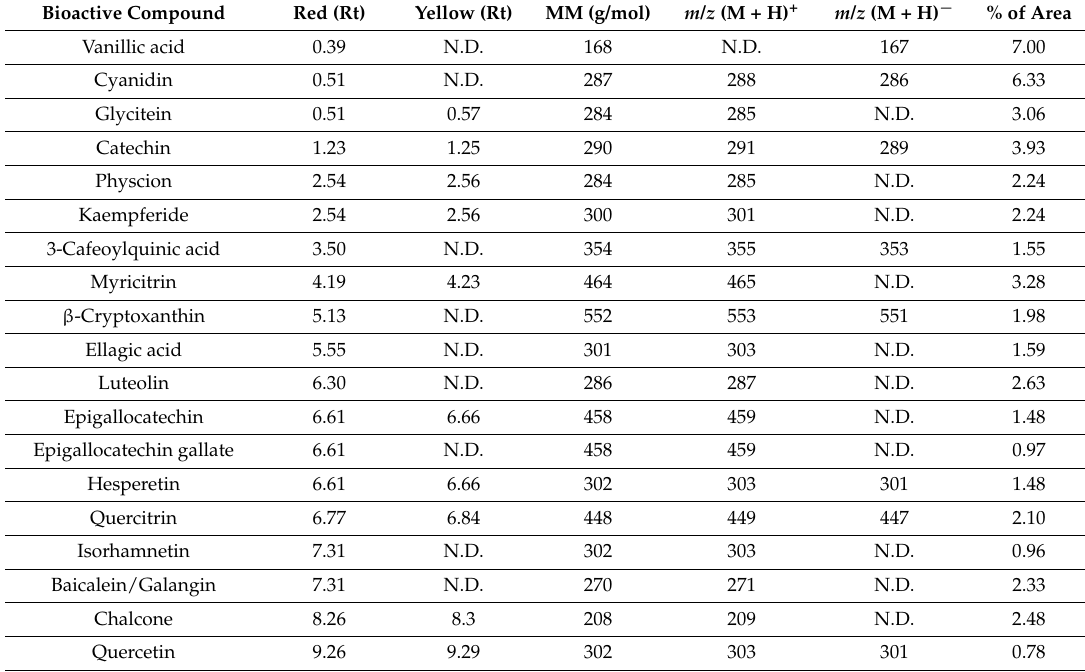
Table 2. Identification of possible bioactive compounds presents in extracts of the edible parts of red and yellow plum by